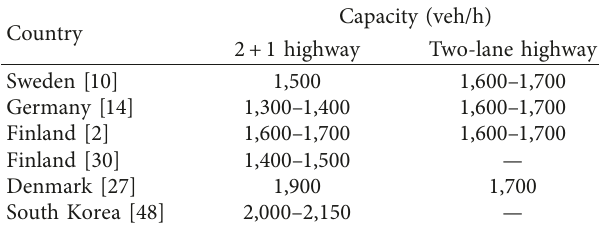
Table 6: Comparison of capacity impacts of 2+1 highways.